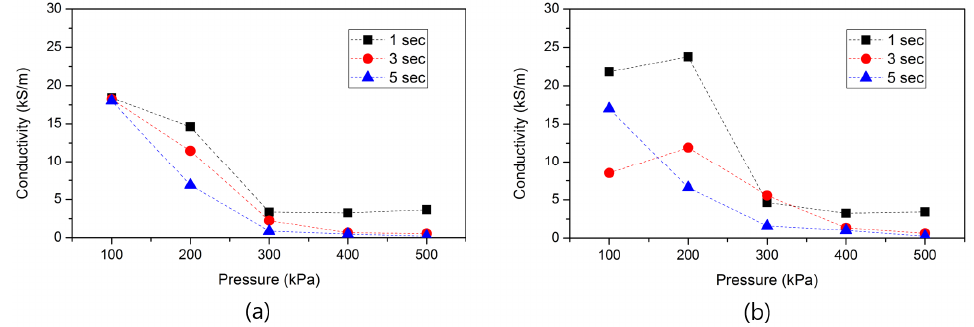
Figure 4. Conductivity of LM film sprayed at a distance of ( a ) 5 cm and ( b ) 10 cm from the substrate for 1 s, 3 s, and 5 s, under various spraying pressures.